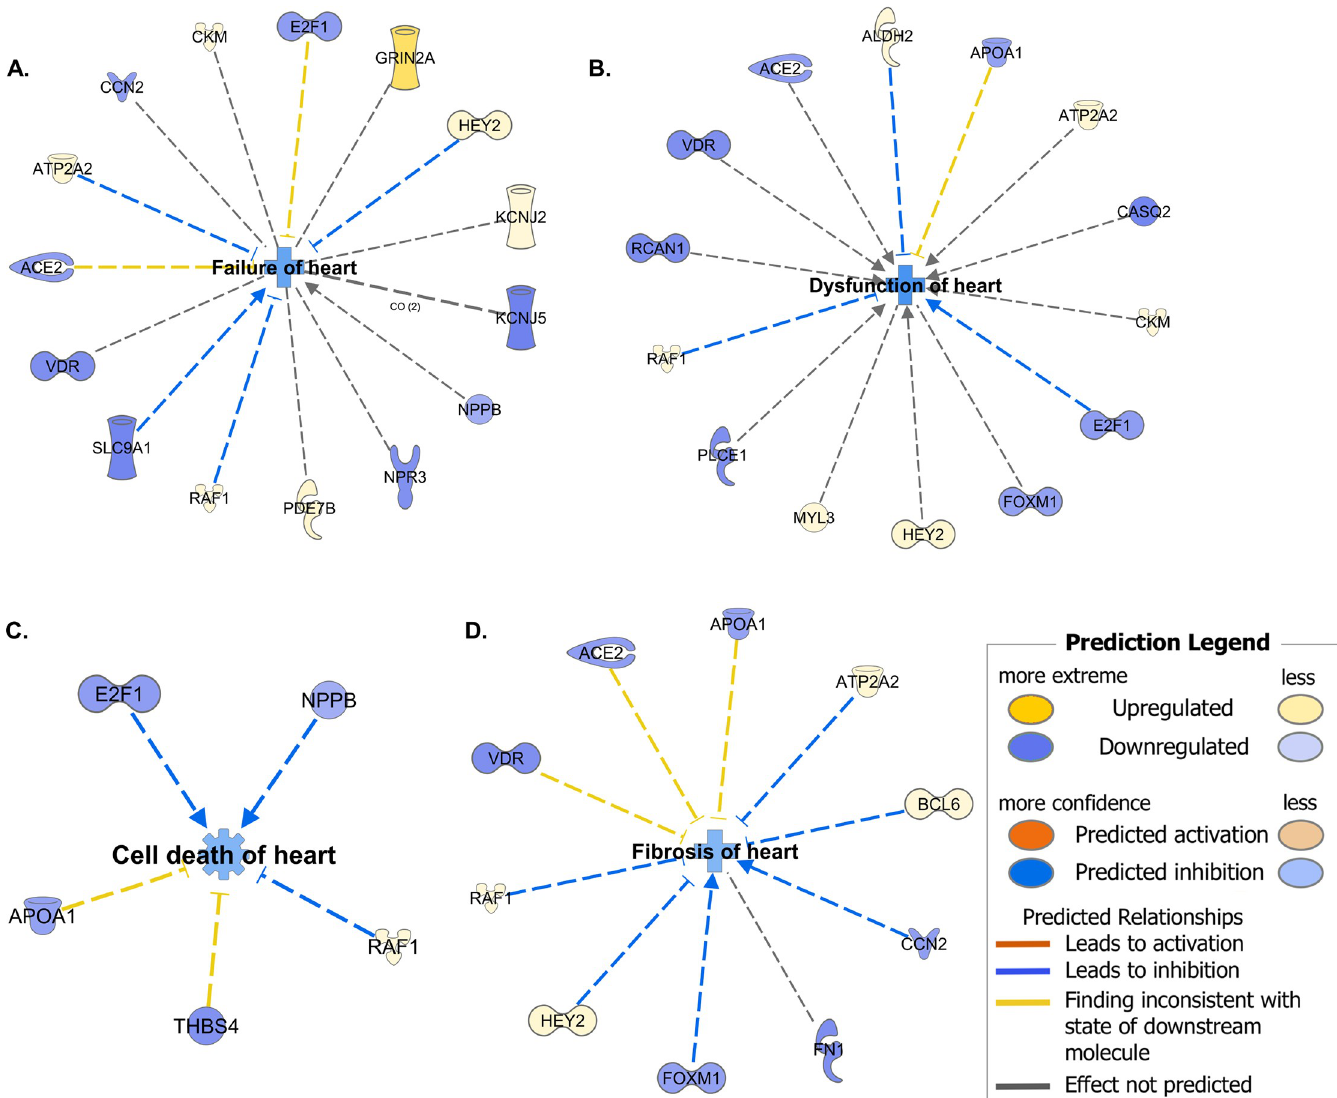
Fig 3. Ingenuity pathway analysis of concordantly changed mRNAs from Table 3. Colors indicate predicted effect of transcript on biological function or disease in center of circular diagram. ( A ) Dysfunction of heart. ( B ) Failure of heart. ( C ) Cell death of heart. ( D ) Dilated cardiomyopathy.